Question: According to the figure, is the described quantity increasing or decreasing?
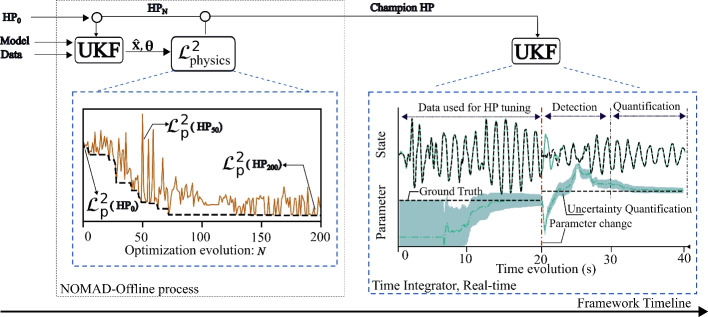
Answer: decreasing